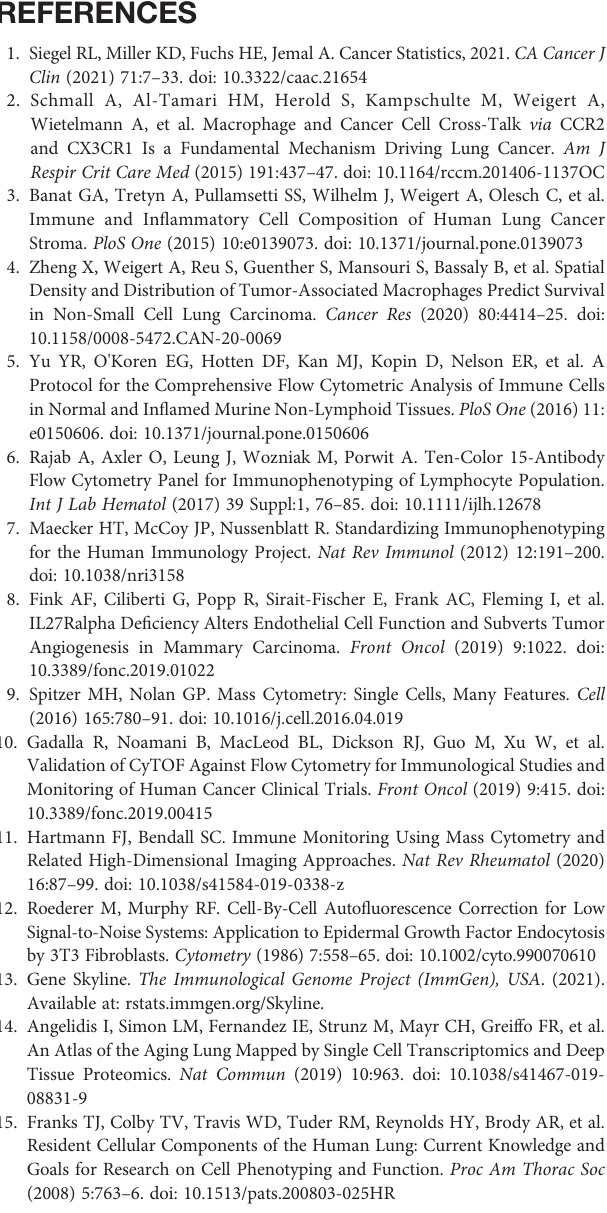
showing the gating strategy with a multispectral antibody panel. BEC, blood endothelial cells; cDCs, conventional dendritic cells; LEC, lymphatic endothelial cells; M Ф , macrophage; NK, natural killer cells; NKT, natural killer T cells; pDCs, plasmacytoid dendritic cell; Treg, regulatory T cell; VSMC, vascular smooth muscle cell. Supplementary Figure S2 | Quanti fi cation of cell subsets derived from CD45 + cells in different lung tumor models. Relative abundance of immune cell populations within the CD45 + cell compartment is shown. Control means healthy lung. i.t., intratracheal injection; i.v., intravenous injection; t.r., tumor relapse model; Macs, macrophages; Mono, monocytes; DCs, dendritic cells; pDCs, plasmacytoid dendritic cells; NK cells, natural killer cells; NKT cells, natural killer T cells; Treg, regulatory T cells. Animal numbers for control n=5, for i.t. model n=6, for KRas model n=9, for tumor relapse model n=9, for i.v. model n=3. *P < 0.05, **P < 0.01, ***P < 0.001, ****P < 0.0001 compared with